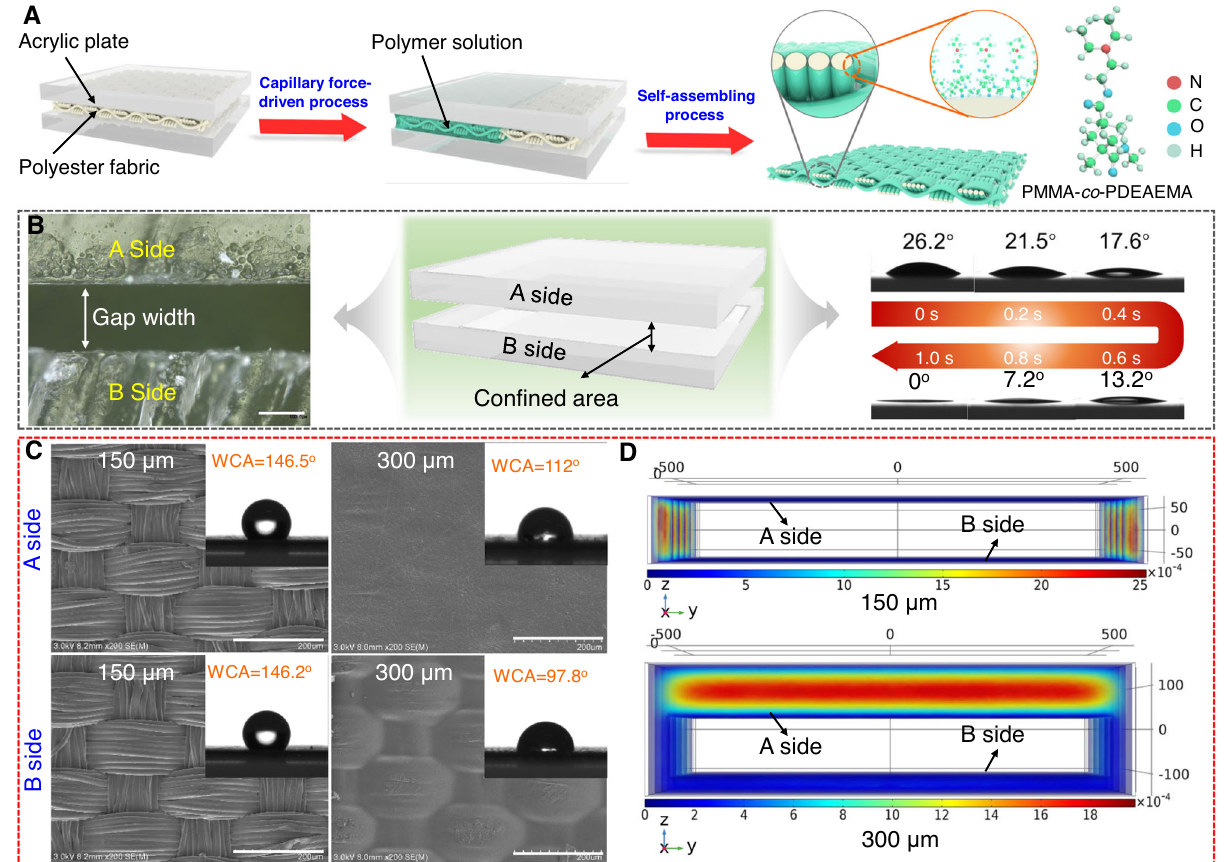
Fig.1|DesignofPPFM.A SchematicillustrationofthefabricationprocessofPPFM through the capillary force-driven con fi nement self-assembling method. B Schematic illustration (middle) and optical image (left) of the formation of a con fi ned area caused by two pieces of superimposed acrylic plates. Dynamic CA transformation (right) of PMMA- co -PDEAEMA copolymerdroplet on the surfaceof the acrylic plate over time. The used droplet is a 10 wt% PMMA- co -PDEAEMA